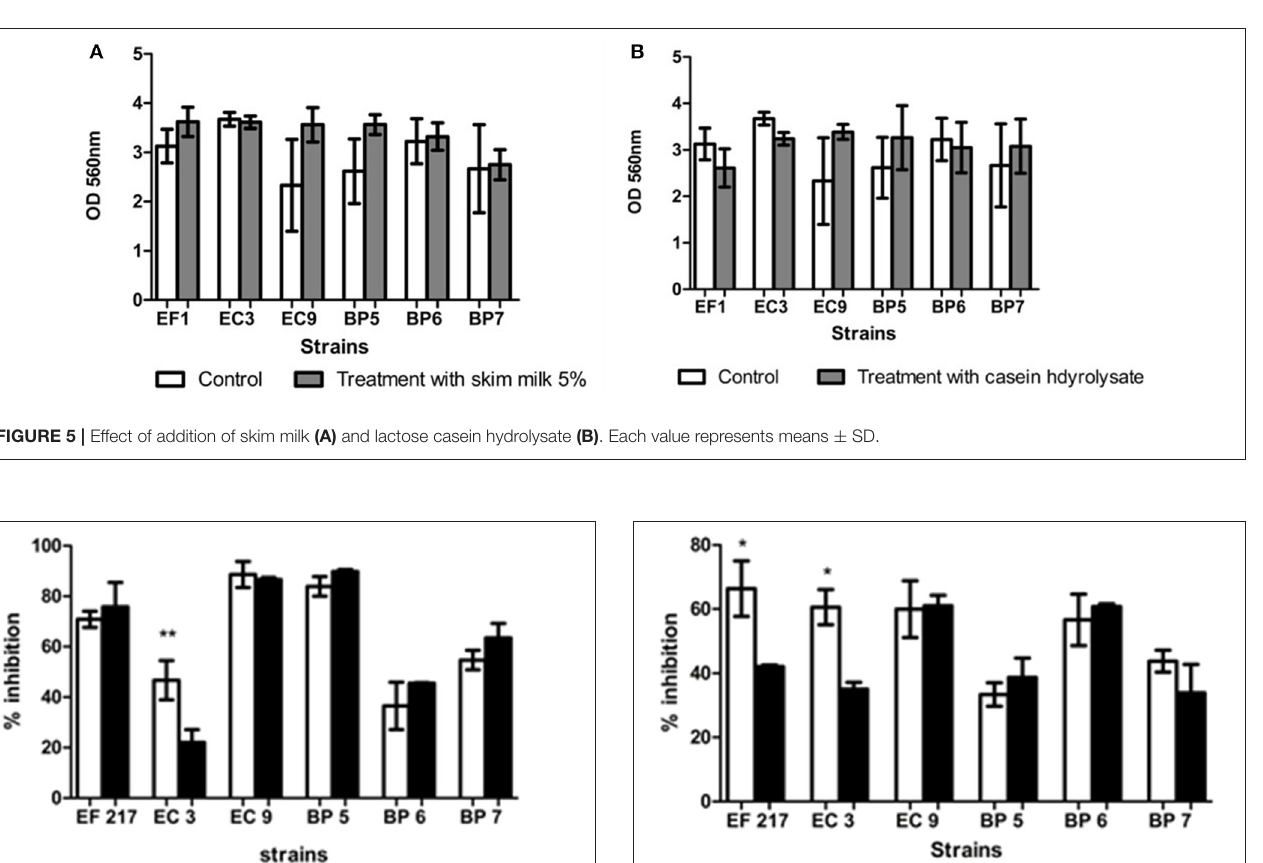
FIGURE 4 | Effect of addition of sucrose (A) and lactose (B) on biofilm formation. Each value represents means ± SD.